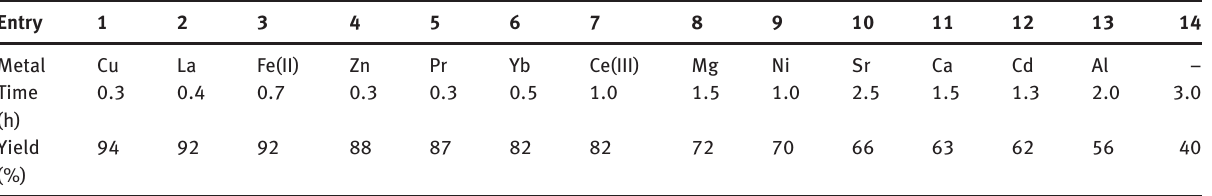
Table 1: Comparison of the catalytic activity among different metal methanesulfonates. Entry